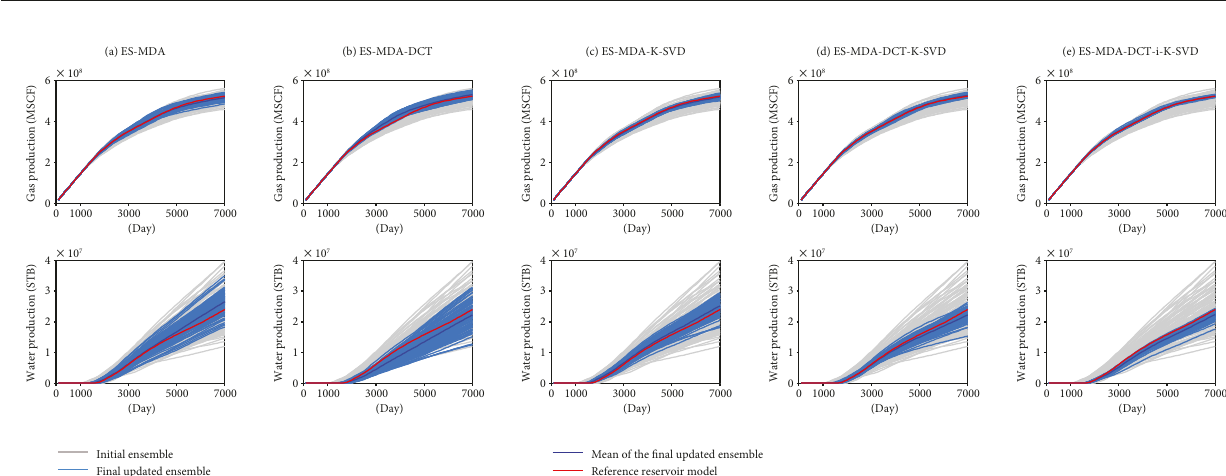
Figure 9: History matching results of Case 1: cumulative gas production and cumulative water production in the fi